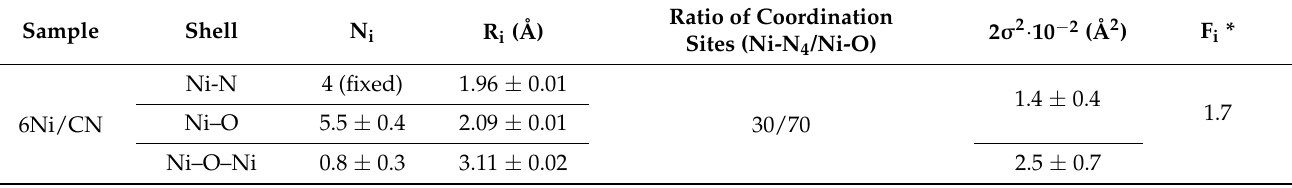
Table 1. Structural data for the 6Ni/CN sample obtained from the fitting of EXAFS spectrum (N i —coordination number; R i —interatomic distance, 2 σ i2 —Debye–Waller factor, F i —a factor repre- senting statistical error of the